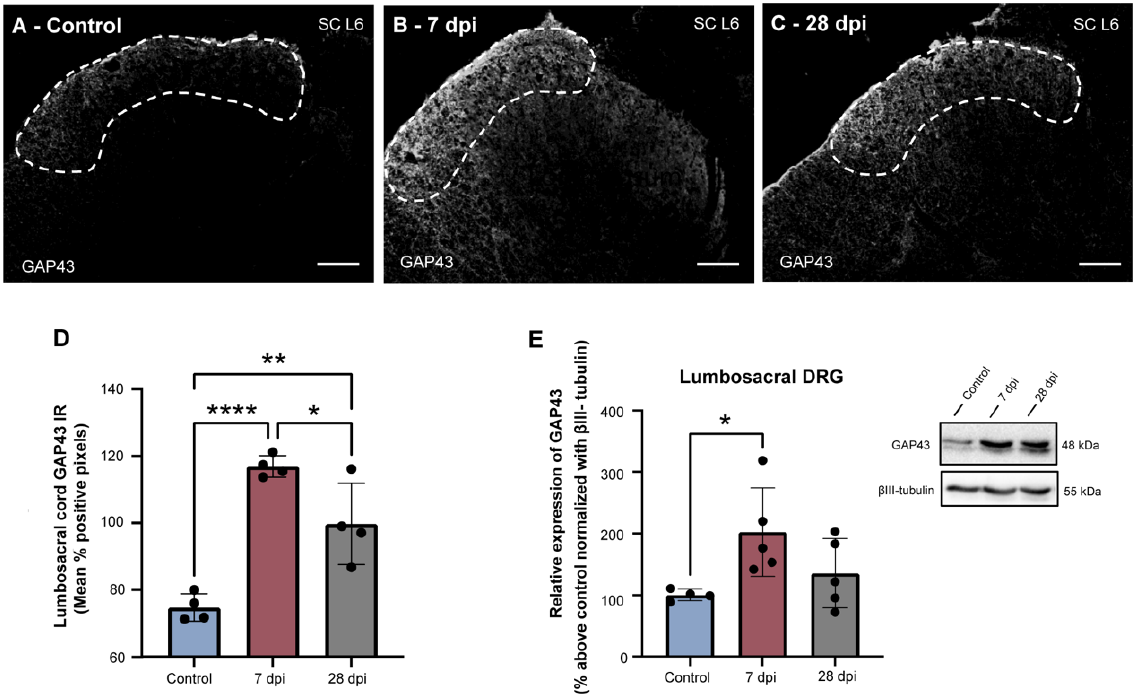
4 of 23 Figure 1. Representative cystometrograms depicting the voiding pattern of animals with intact spines (control) and after spinal cord injury. Control animals exhibited a normal pattern of bladder